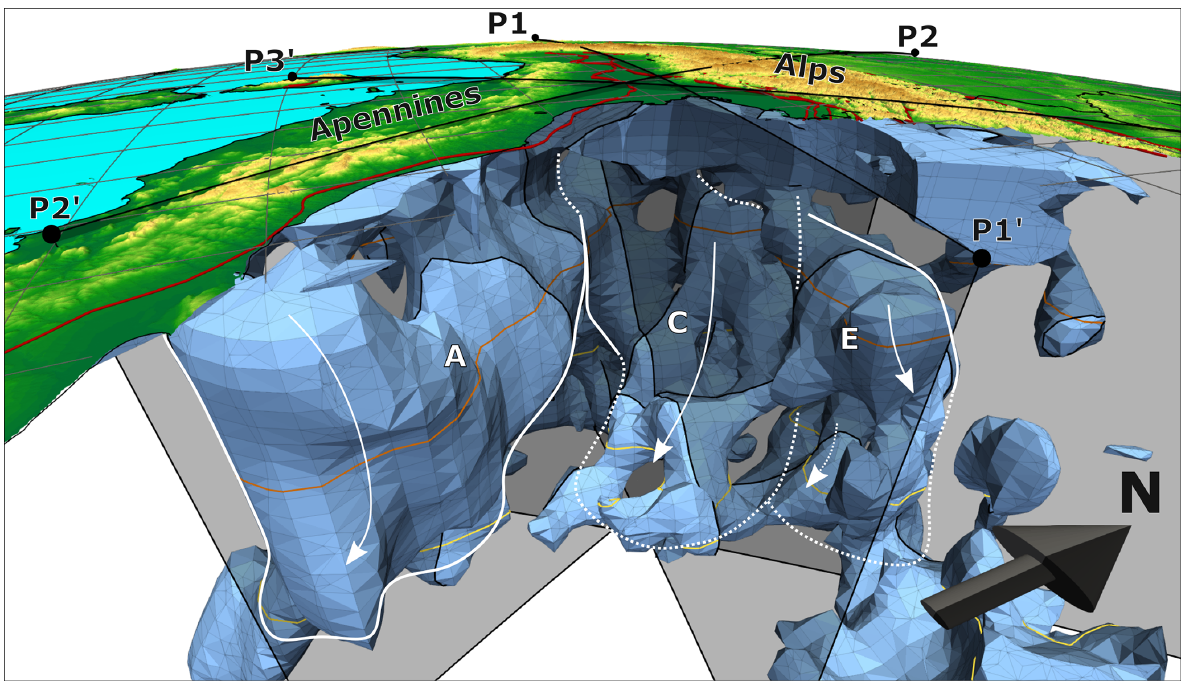
Figure 17. Three-dimensional view from the southeast (Adria) into the resulting model after 12 inversion iterations. We show here velocity iso-surfaces for an increase of 1 . 25% in P-wave velocity. High-velocity structures in the SE that would block the view have been clipped. The three vertical profiles P1, P2 and P3 are indicated as semi-transparent surfaces as well as the respective contours of the iso-surfaces along these profiles (black lines). The 410km discontinuity is shown as a thin yellow line on the anomalies, as well as the outline of the horizontal slice at 180km depth (thin brown line). Associations of the 3D high-velocity bodies with the interpreted slabs and the velocity anomalies (A), (C) and (E) defined in the horizontal and vertical cross sections are indicated by white